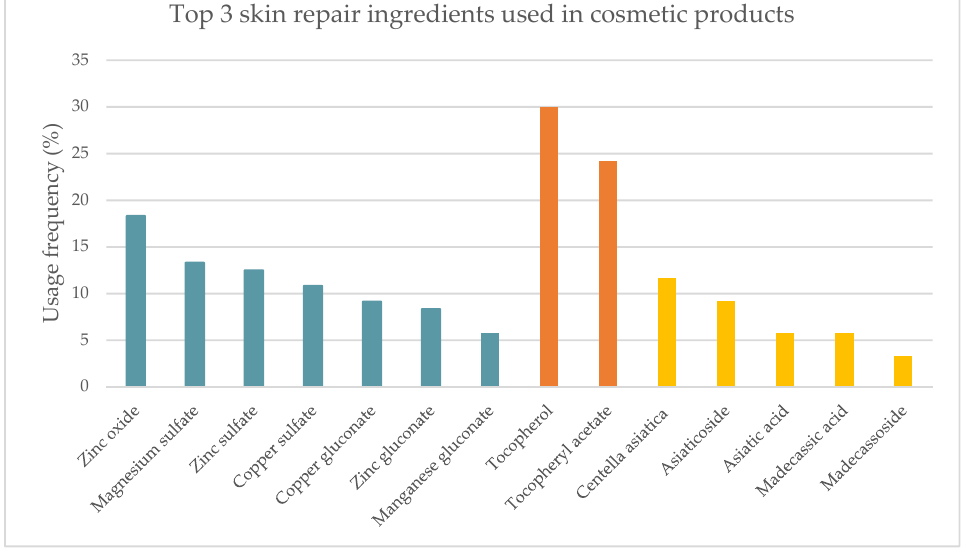
Figure 3. Usage frequency of the top 3 skin repair ingredients in cosmetics extended: metal salts and oxides (blue), vitamin E and derivatives (orange) and C. asiatica and pure compounds (yellow).